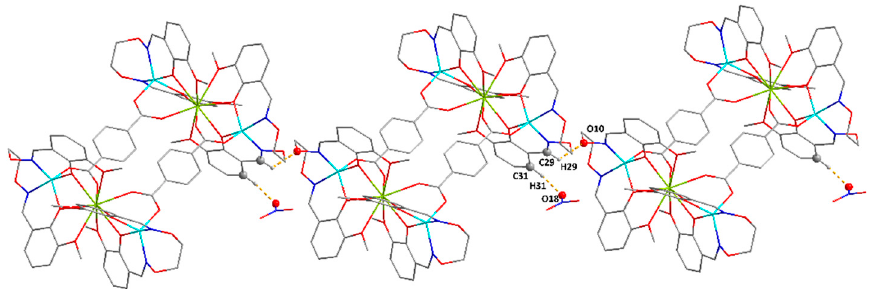
Figure 4. Intramolecular hydrogen bonding interactions of the Zn(II)-La(III) coordination compound (hydrogen atoms, except those forming hydrogen bonds, are omitted for clarity).